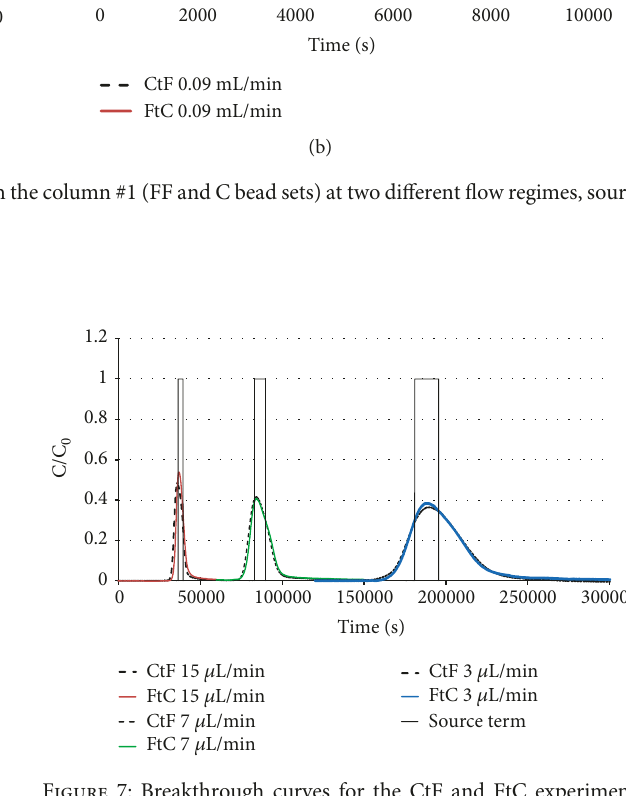
Figure 7: Breakthrough curves for the CtF and FtC experiments with column #1 (FF and C bead sets), for an injection of 0.7mL of 0.1 M solution of sodium